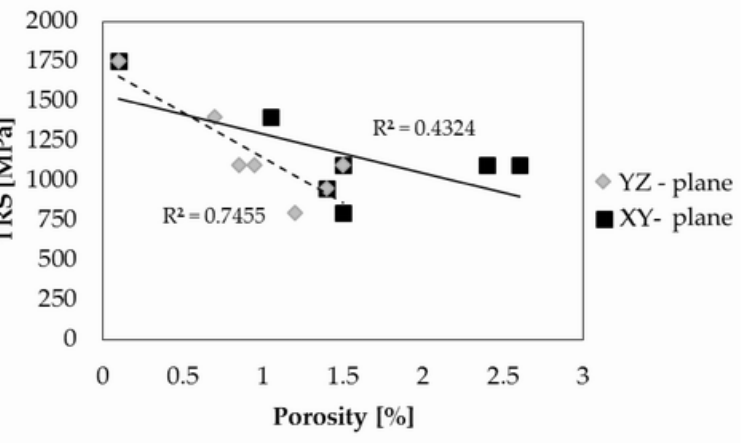
Figure 6. Correlation between porosity in the direction of pressing and transverse rupture